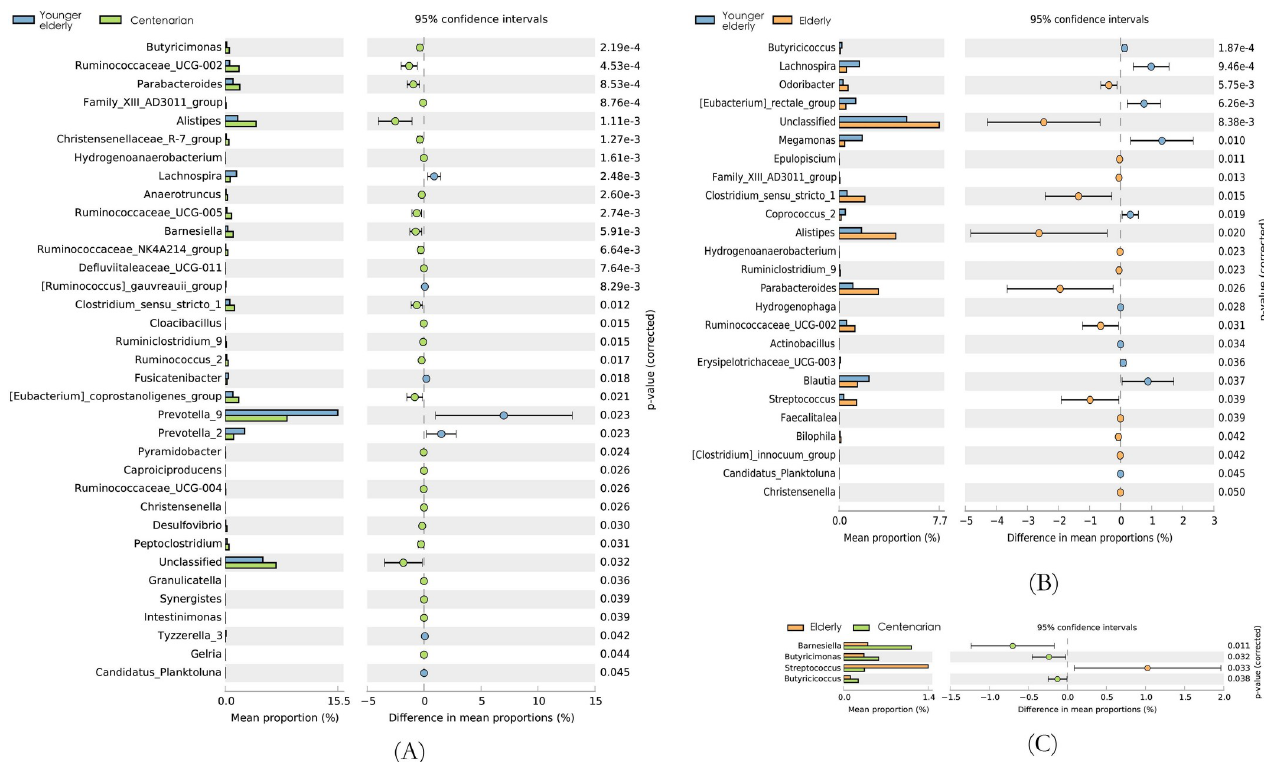
Fig 2. Relative abundance among three age groups at genus levels with p values. (A) Different relative abundance between the 65–70 and 100+ year age groups with 95% confidence interval and p values. (B) Different relative abundance between the 65–70 and 90–99 year age groups with 95% confidence interval and p values. (C) Different relative abundance between the 90–99 and 100+ year age groups with 95% confidence interval and p values.